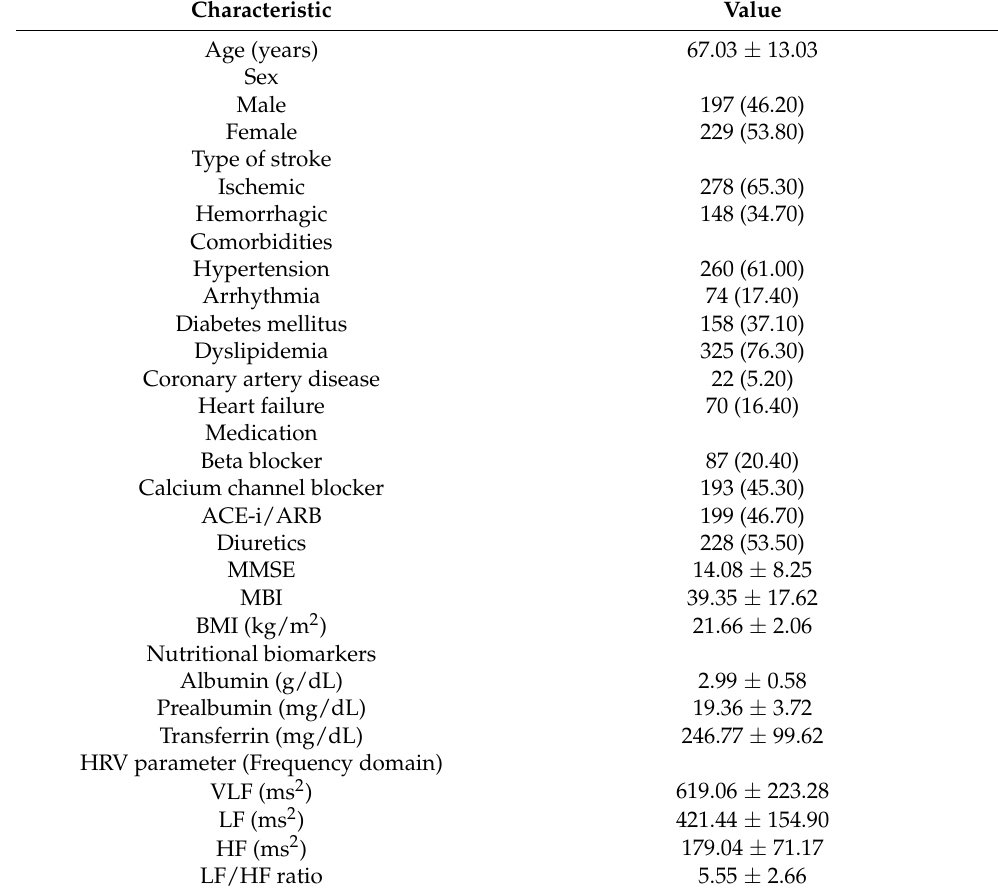
Table 1. Clinical characteristics of